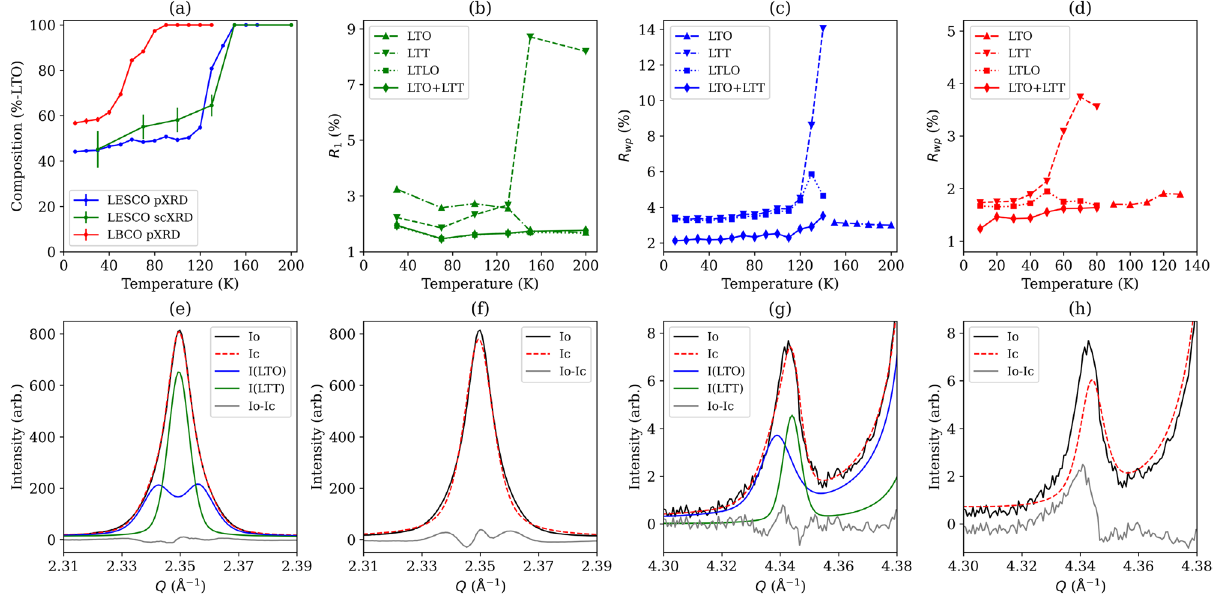
Figure 2. Top left to right, plots of: ( a ) the refined percentage of the LTO phase in the LESCO scXRD and pXRD and in LBCO pXRD data, showing errors as estimated by SHELX and TOPAS (error bars drawn at 3σ confidence level; a discussion of the accuracy of these is provided in the Methods section); ( b ) SHELX outputted R 1 fit-factor for all reflections for the LTT, LTO, LTLO and LTO+LTT single-crystal refinements of LESCO; and the R wp fit-factors for the LTT, LTLO, LTO+LTT and LTO models for the pXRD of ( c ) LESCO and ( d ) LBCO. Bottom left to right, plots of pXRD refinement fits of: ( e ) the dual-LTO+LTT and ( f ) single-LTT models to the (2 0 0)/(0 2 0) peak set at 50 K for LESCO; and the same models for ( g ) and ( h ), respectively, fit to the (2 3 2)/ (3 2 2) peak set for LESCO. For ( e ) and ( g ) we show explicitly the two components that contribute to the overall calculated trace; equivalent plots for LBCO in Supplemental Fig. 9 and include a reflection of class hhl for